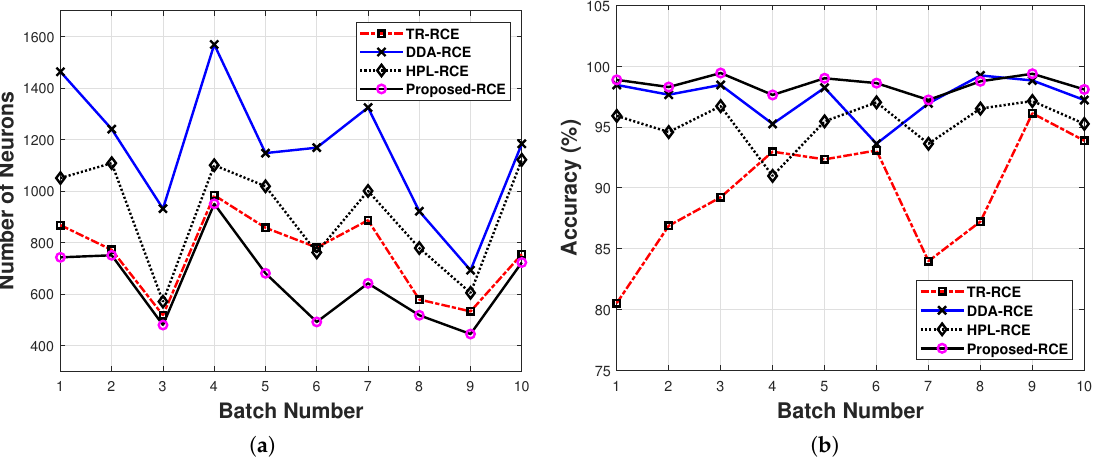
Figure 4. Performance evaluation results for motion-capture hand postures (MCHP) dataset ( a ) The number of learned neurons for each batch, ( b ) The recognition accuracy for each